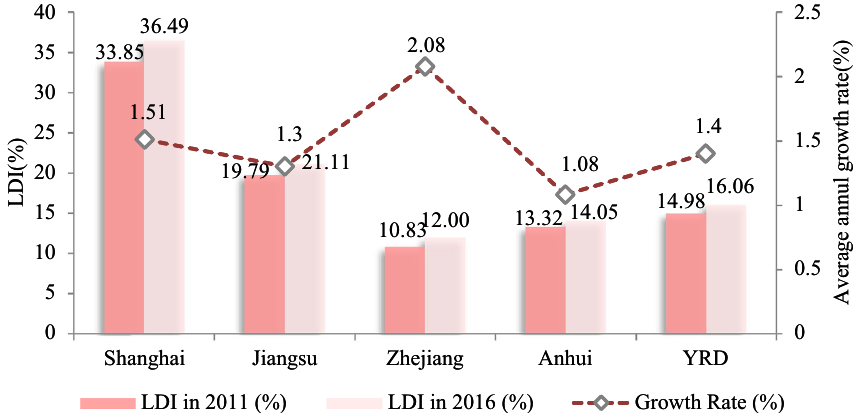
Figure 2. LDI in the YRD from 2011 to 2016. Software: Excel 2010. URL: https:// www. micro soft. com/ zh- cn/.